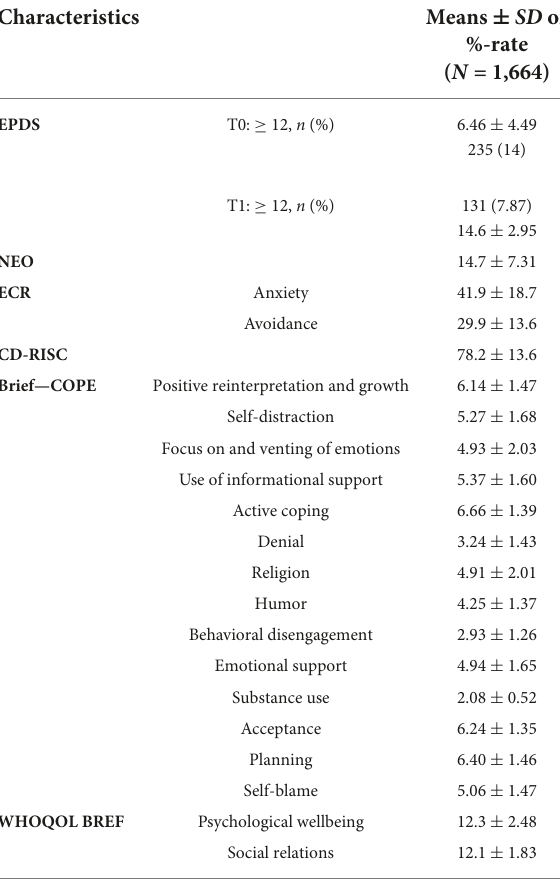
TABLE 3 Psychological assessment at intake (T0; N =